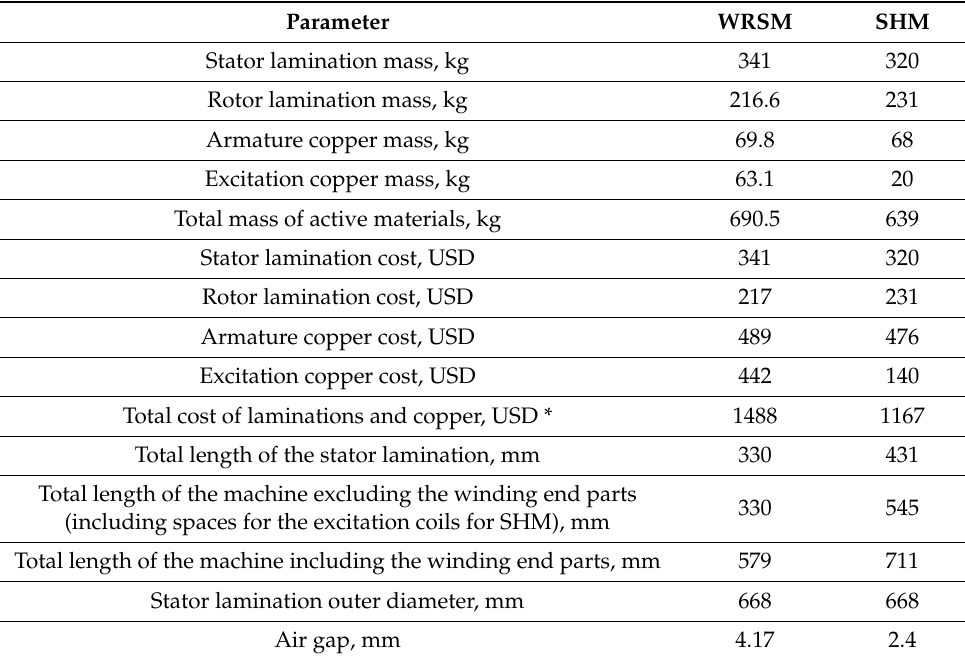
Table 6. Comparison of masses, costs, and dimensions of parts of the optimized WRSM and